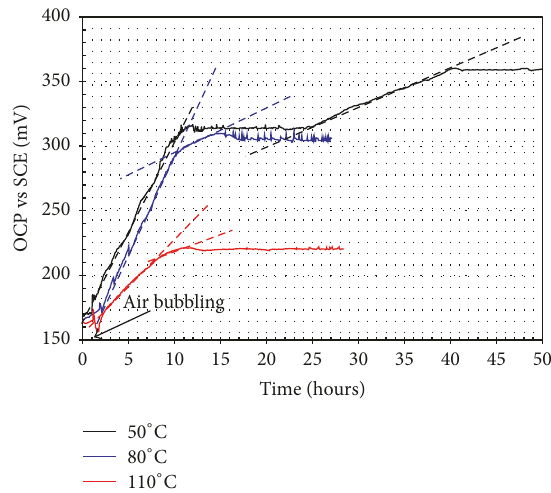
Figure 7: OCP measurements during the oxidation of the raw oil at different